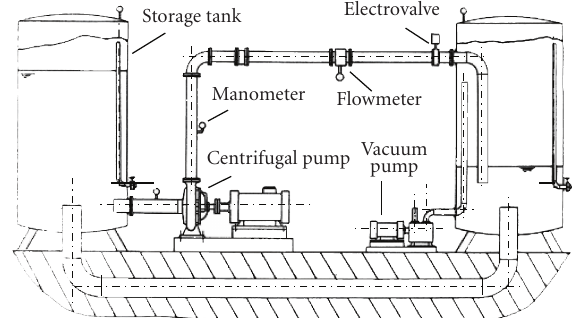
Figure 3: A scheme of the LEMFI pump test-ring.